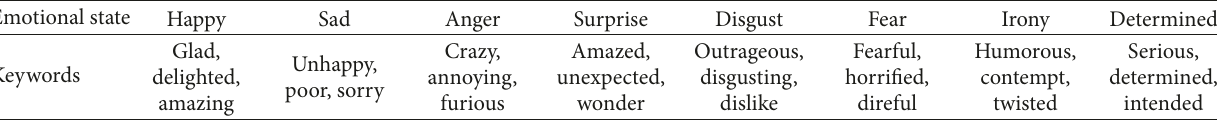
Table 2: Example of keywords used to identify emotional state. Emotional state